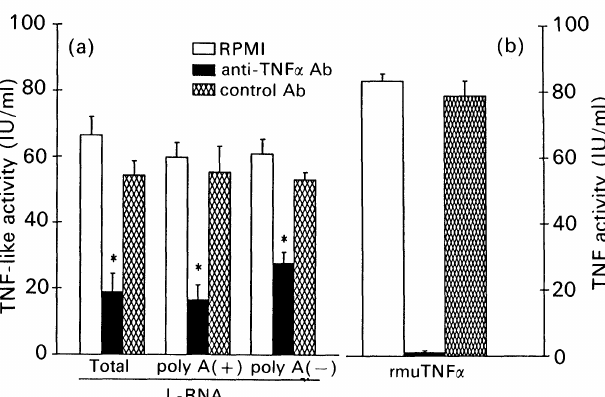
___ FIG. 2. The effect of poly A(+)-RNA and poly A(-)-RNA fractions on the release of TNF- by resident macrophages. Panel A" Macrophage monolayers were incubated with total L-RNA (25/g/ml), or with the poly A(+)- (0.5 #g/ml) or poly A(-)-RNA fractions (25/g/ml) for 6 h. The supernatants were then incubated at 37C for 10 min prior to performing the cytotoxicity assay with RPMI medium, rabbit anti- rmuTNF- antibody or control antibody (serum from a non-immunized rabbit). Panel B: A sample of rmuTNF-z was used as a control for the TNF assay. Results are the mean S.E.M. of at least two experiments performed in quadruplicate. *p < 0.01 compared with control values (ANOVA; Duncan’s